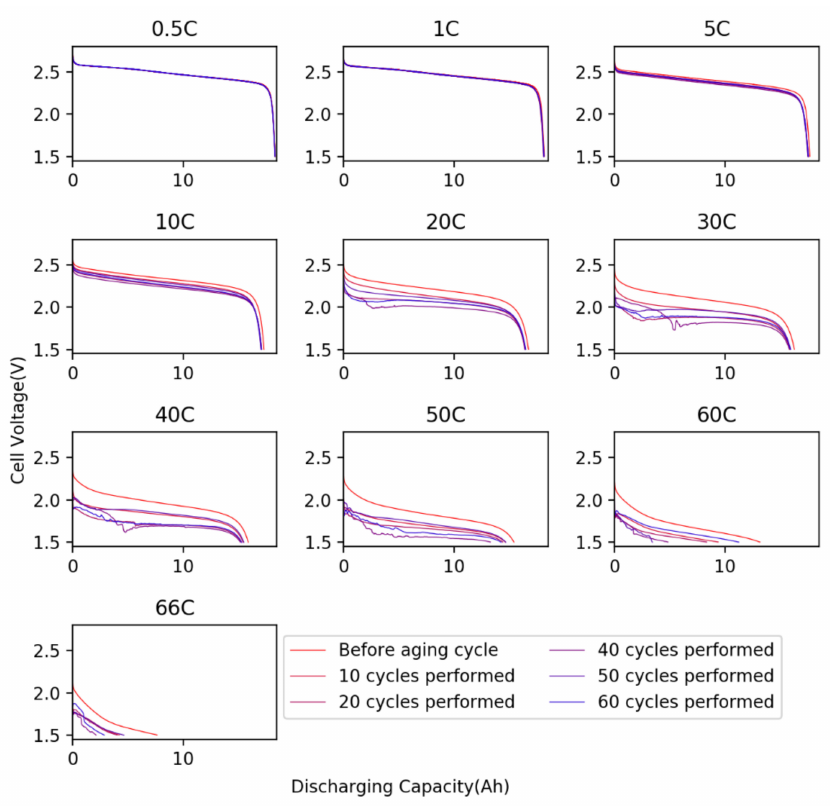
Figure 6. The discharging curves at different current rates during aging cycles of cell